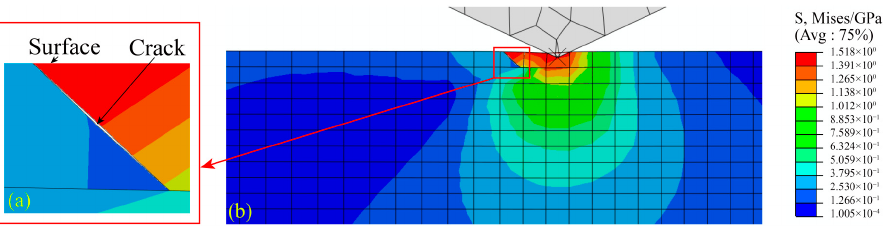
Figure 3. Application cloud diagram of CrN-3Pt coating surface when cracks start to appear: ( a ) Crack enlargement, ( b ) State of crack.